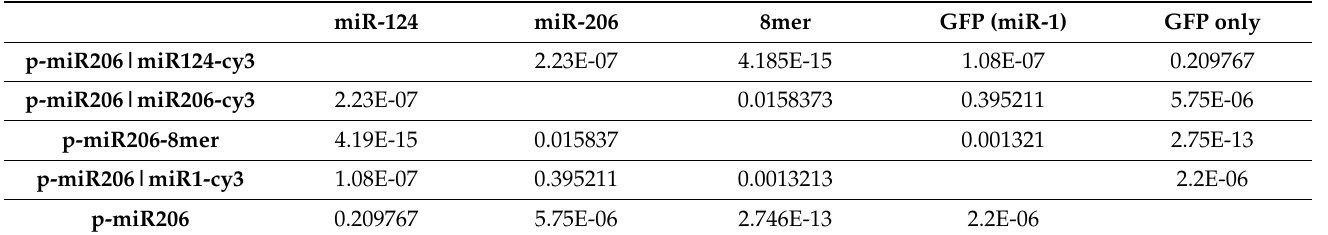
Table 5. Descriptive statistics for Figure 2C—modifications in p-miR206-GFP target